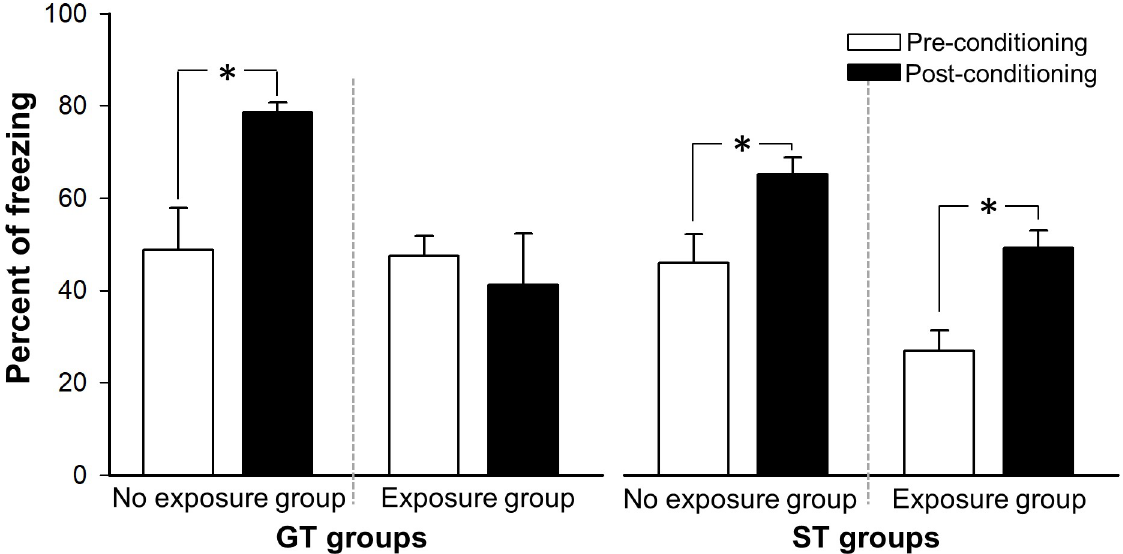
Fig 5. Mean of freezing response in GT and ST groups exposed and non-exposed to the future CS in a LI test. Asterisks indicate the conditioning after CS-US association (p <